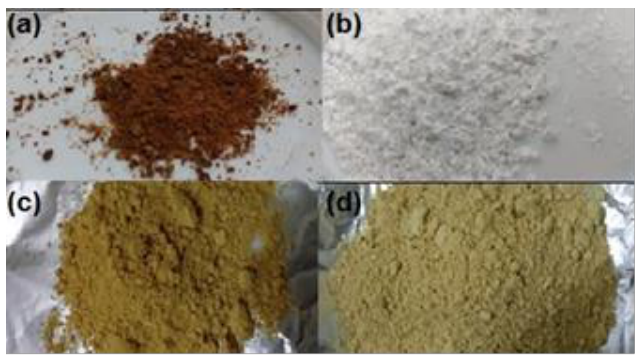
Fig.1. Spray drying powder results: (a) Propolis without encapsulation; (b) maltodextrin-gum Arabic; (c) SDMP rough type; and (d) SDMP smooth type